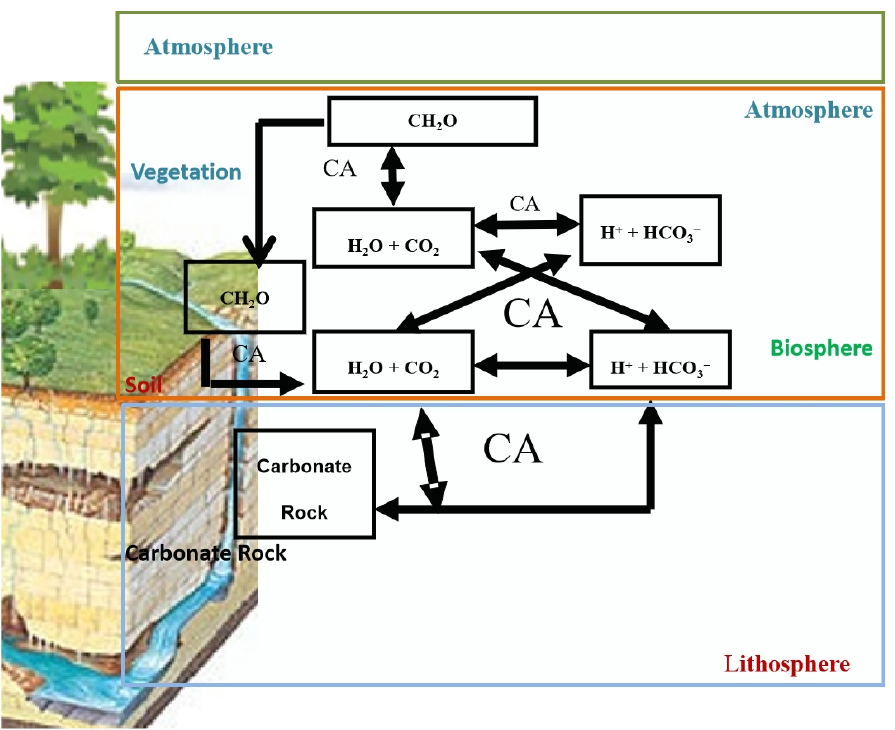
Figure 3. Carbonic anhydrase is pivotal in karstification–photosynthesis coupling. Carbonic anhy- drase (CA) catalyzes the dissolution of carbonate rocks at the rock–soil interface, the hydration of CO 2 in the soil solution and soil–atmosphere and soil–vegetation interface, the photosynthesis of plants, etc.